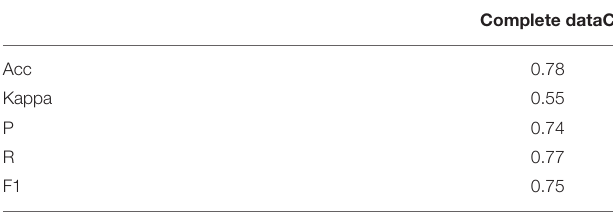
TABLE 9 | Prediction measures of the ensemble